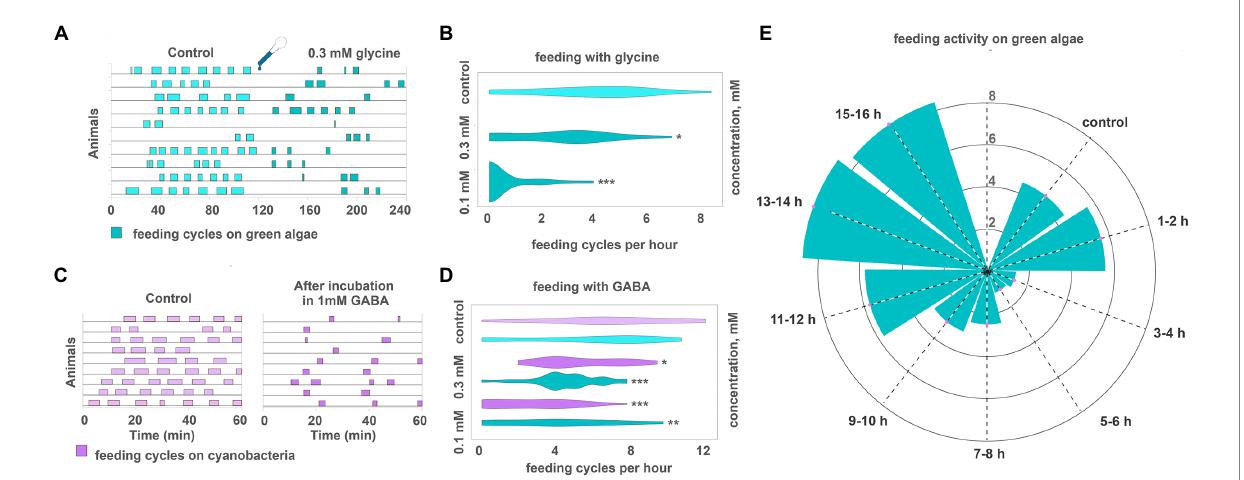
FIGURE 6 GABA and glycine modulate feeding cycles in Trichoplax adhaerens . (A) After adding 0.3 mM glycine, the number, and frequency of feeding cycles on green algae biofilm reduced approximately threefold compared to the control. (B) The effect of glycine on feeding activity is dose-dependent. 0.1 mM reduces the number of feeding cycles by 26%, 0.3 mM—by 86%. Asterisks denote a significant difference in feeding activity from the control (Welch t -test, * p < 0.05, *** p < 0.001). N animals = 65, 36, 29. (C) After 20 h in 1 mM GABA (C , right ) , the number and frequency of feeding cycles reduced approximately threefold compared to the control [after 20 h in pure artificial seawater (ASW)] (C , left ) . In control, Trichoplax exhibit feeding cycles every 10–15 min. (D) GABA decreased feeding activity on green algae and cyanobacterial biofilms in concentrations of 0.3 and 1 mM. Asterisks denote a significant difference in feeding activity from the control (Welch t -test, * p < 0.05, ** p < 0.01, *** p < 0.001). N animals = 80, 64, 27, 26, 47, 40. (E) After adding 0.3 mM GABA, feeding activity decreased on the green algal mat ( T. marina ) after 1–2 h from the starting point and recovered after 11–12 h of incubation. N animals =